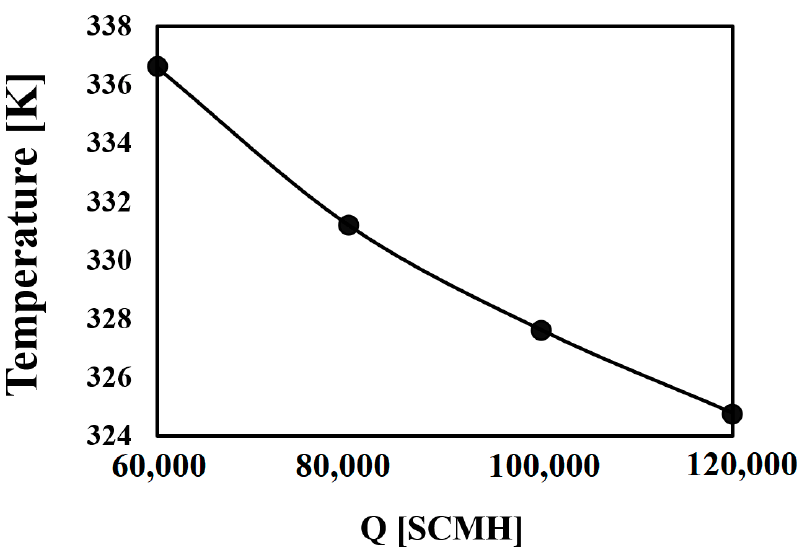
Figure 13. The variation in the shell (water) temperature against the inlet mass flow rate.